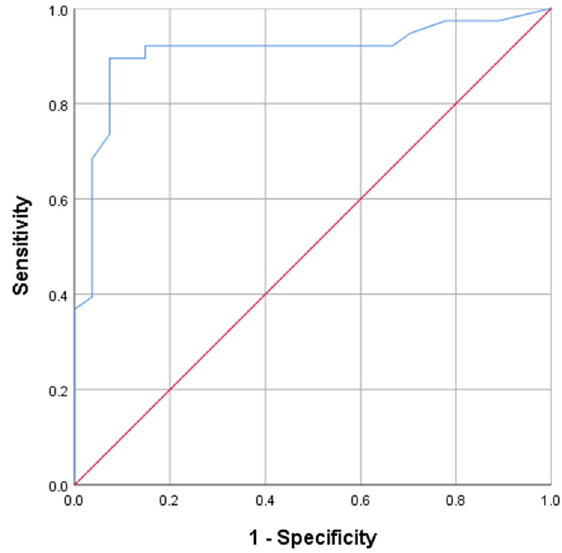
Figure 1. ROC curve for PFS1.